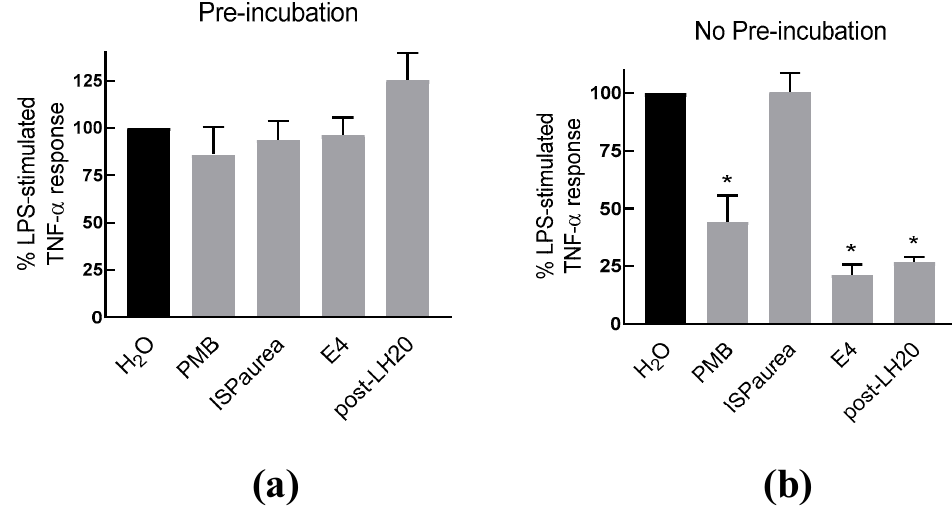
Figure 5. The inhibitory effect of AIPetinc on LPS-stimulated TNF- α response requires co-incubation with LPS. ( a ) LPS-stimulated TNF- α production in RAW264.7 cells with pre-incubation of mushroom extracts isolated from P. aurea (ISPaurea) or E. tinctorium crude extract (E4) and the semi-purified fraction post-LH20. After incubation for six hours with the indicated extracts and controls, the cells were washed two times before LPS was added for a further six hours incubation. TNF- α production in the medium was then measured. ( b ) LPS-stimulated TNF- α production in RAW264.7 cells co-incubated with mushroom extracts. Error bars are S.D., obtained from three biological replicates ( n = 3), and one-way ANOVA was performed as statistical analysis. * denotes p < 0.05 as compared to H 2 O control using Sidak’s multiple comparison test.